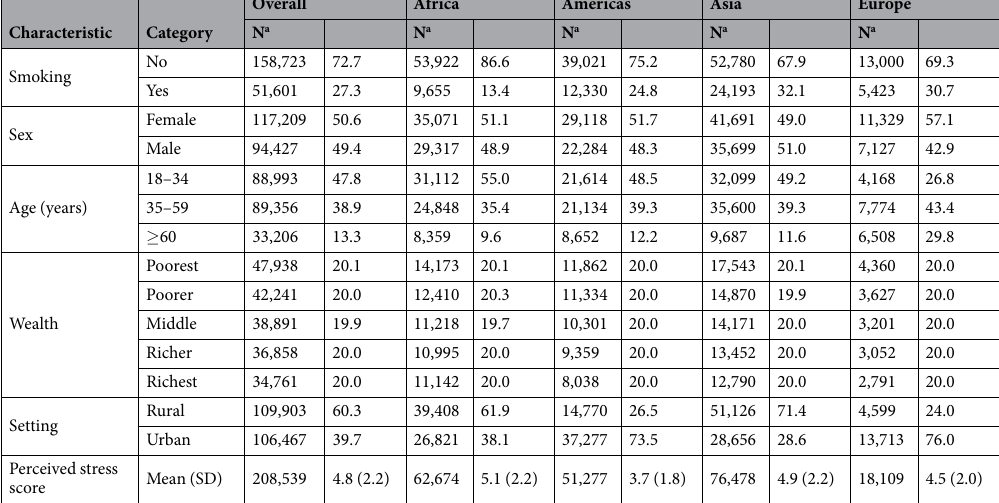
Table 1. Sample characteristics (overall and by region). a Unweighted N. Data are percentage unless otherwise stated. Percentage and mean (SD) are based on weighted sample. b The perceived stress score ranged from 2–10 with higher scores corresponding to higher levels of perceived